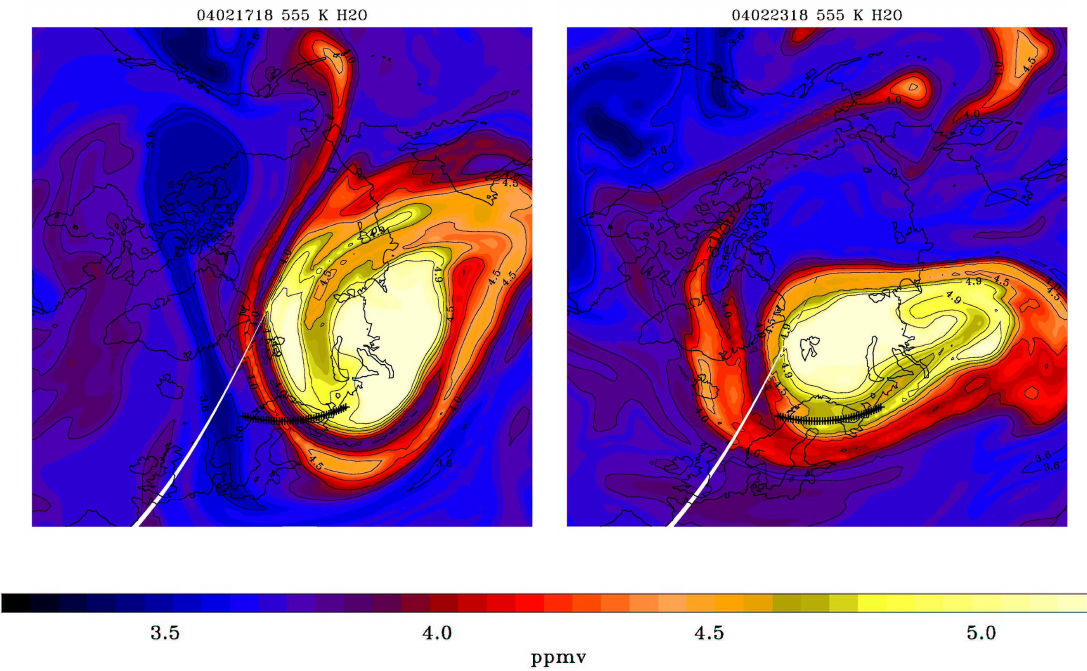
Figure 3. Water vapour from ECMWF advected with MIMOSA on the 555 K level on 17 February 2004 (left) and on 23 February 2004 (right). The black line shows the location of the cross-section shown in Figures 6 and 7.